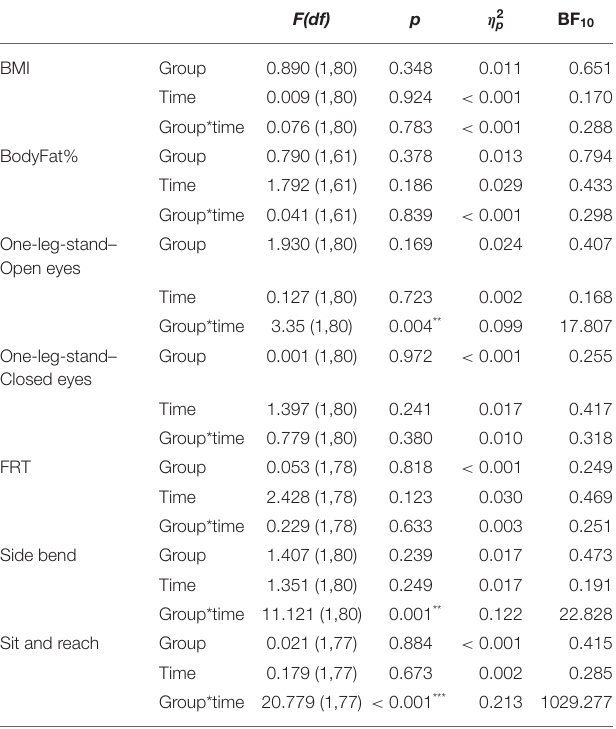
TABLE 2 | Results of the 2 × 2 ANOVAs (both frequentist and Bayesian) for the physical variables. F(df) p η 2 p